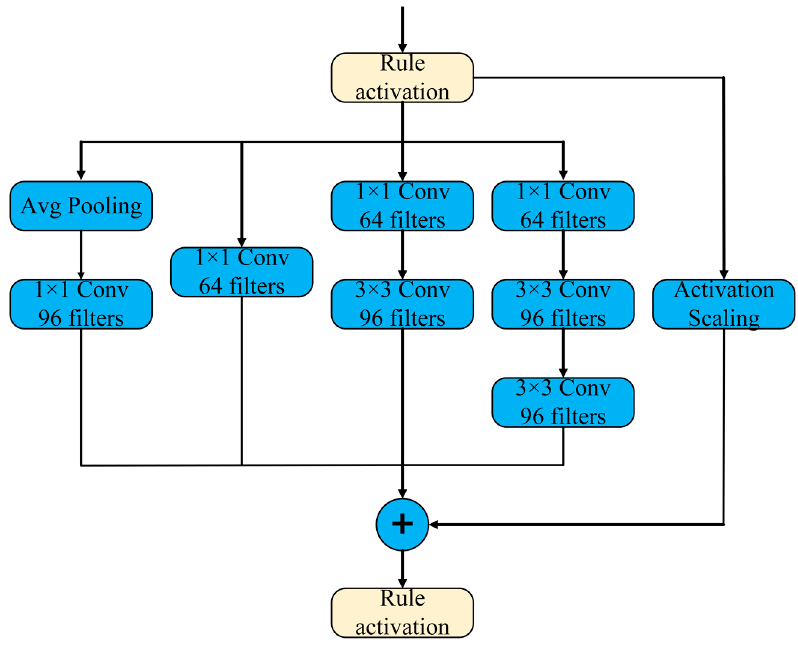
Figure 2. The architecture of Inception-A block from Inception-V4.